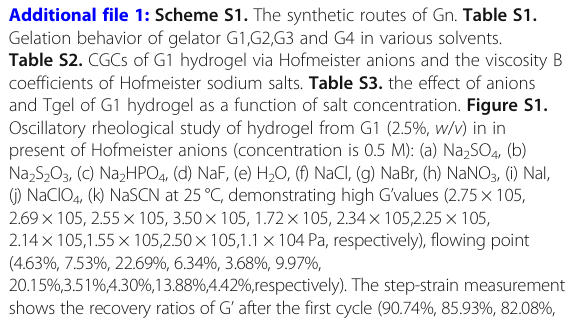
Table S2. CGCs of G1 hydrogel via Hofmeister anions and the viscosity B coefficients of Hofmeister sodium salts. Table S3. the effect of anions and Tgel of G1 hydrogel as a function of salt concentration. Figure S1. Oscillatory rheological study of hydrogel from G1 (2.5%, w / v ) in in present of Hofmeister anions (concentration is 0.5 M): (a) Na 2 SO 4 , (b)